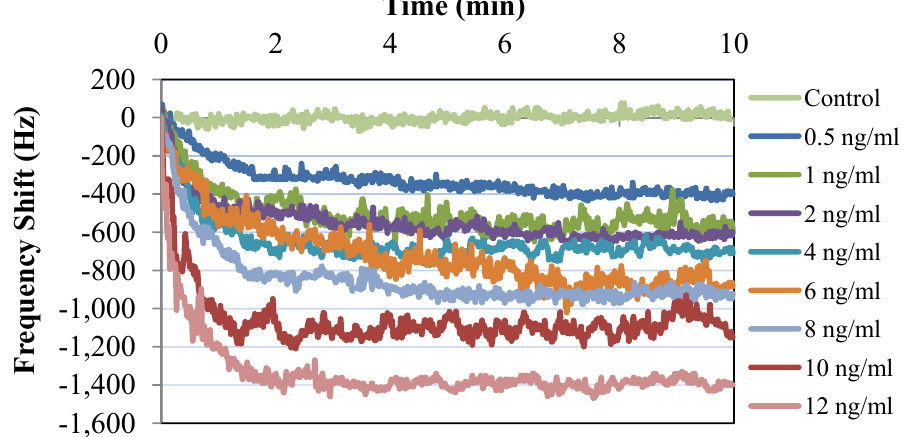
Figure 9. Measured frequency shift (Hz) for various concentrations of Bcl-2 in DPBS.